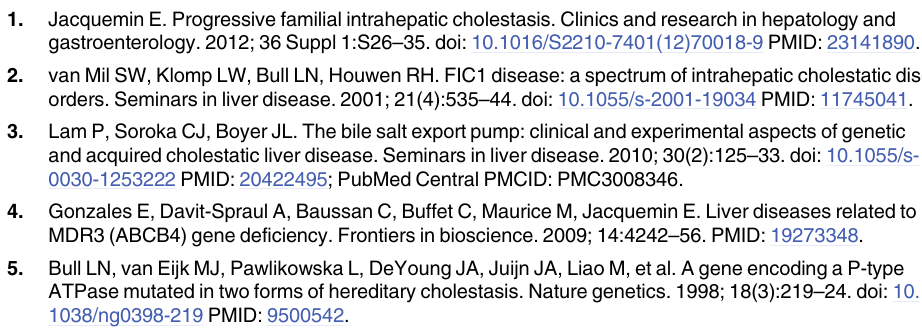
S1 Fig. Pairwise sequence alignment (clustal format) of human BSEP and multidrug resis- tance protein 1A (MDR1A) from mouse. The grayed residues in MDR1A sequence corre- spond to a disordered region with atomic coordinates missing in the crystal structure employed as the template for homology modeling (PDB accession code 4M1M, chain A). The two grayed regions in BSEP sequence highlight, in the order, an insertion with respect to MDR1A and to a region homologous to the disordered region of MDR1A. Amino acids highlighted in red indicate the residues affected by the mutations E135K, R1050C, R1153H, and the position of the first residue involved in the L1099LfsX38. S2 Fig. Pairwise sequence alignment of human ABCB4 and multidrug resistance protein 1A (MDR1A) from mouse. The grayed residues in MDR1A sequence correspond to a disor- dered region with atomic coordinates missing in the crystal structure employed as the template for homology modeling (PDB entry 3G5U, chain A).